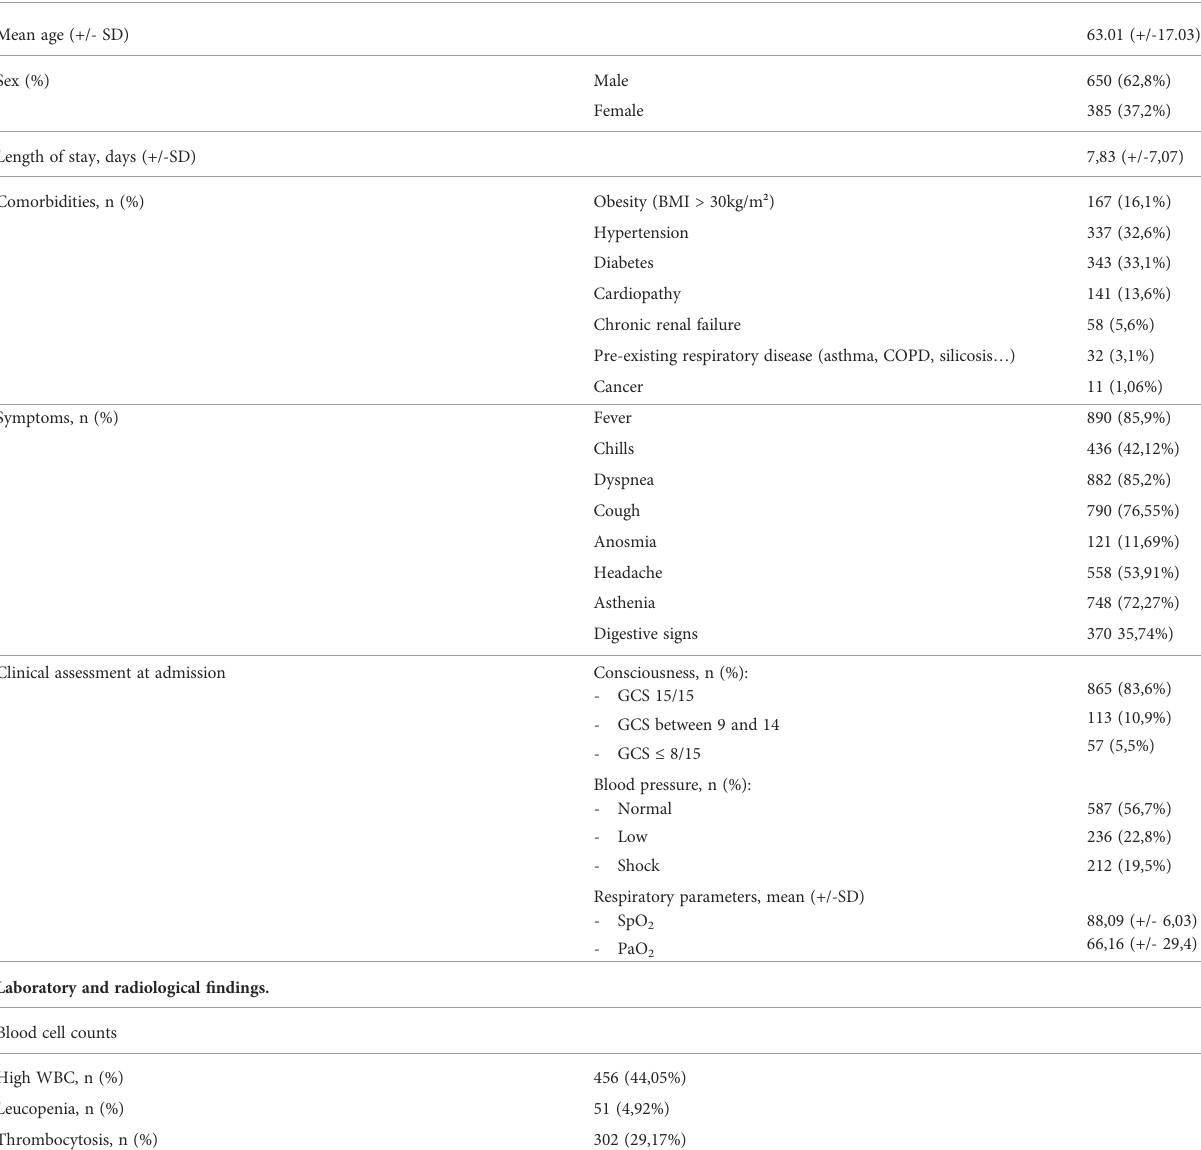
TABLE 1 Summary of the demographic and baseline characteristics, laboratory/radiological fi ndings, and Treatments/outcome of the patients. Demographic and baseline